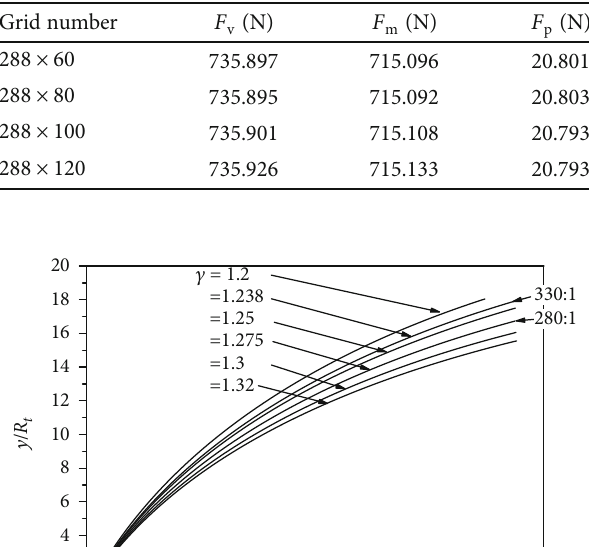
Figure 5: Comparison of the heat capacity ratio obtained with di ff erent assumptions. Table 1: Calculation results with di ff erent grid